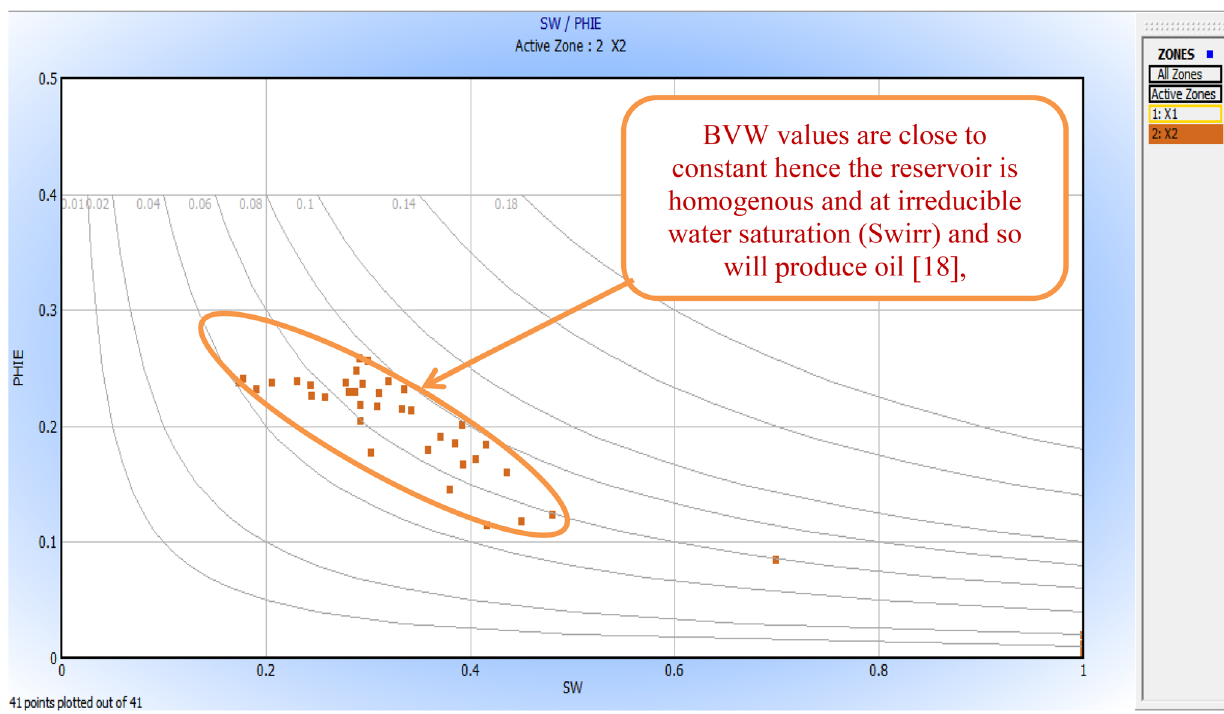
Fig. 10 Porosity versus Water Saturation plot for Reservoir X is at irreducible water